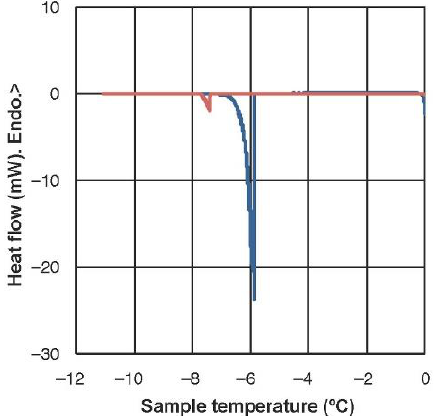
(average ± SE) in fully hydrated leaves (100% RWC), while it occurred at − 6.62 ± 0.06 ◦ C in partially dehydrated leaves (55% RWC).